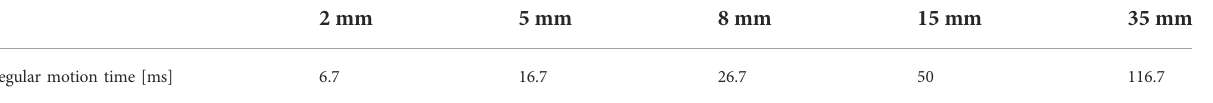
TABLE 2 Cell travel times for all reactor